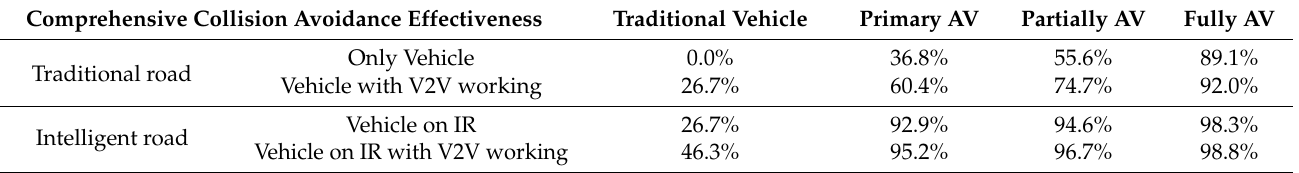
Table 2. Comprehensive collision avoidance effectiveness of different levels of autonomous vehicles driving on the traditional or intelligent